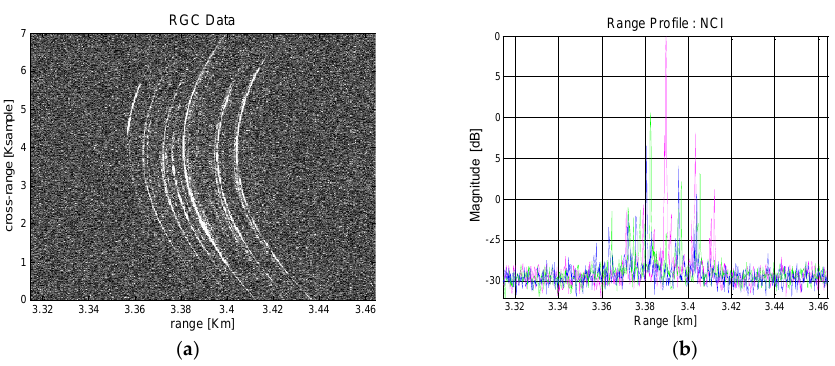
Figure 9. Boeing 747 ISAR data after range compression: ( a ) Range compressed image; ( b ) Integrated range profiles.